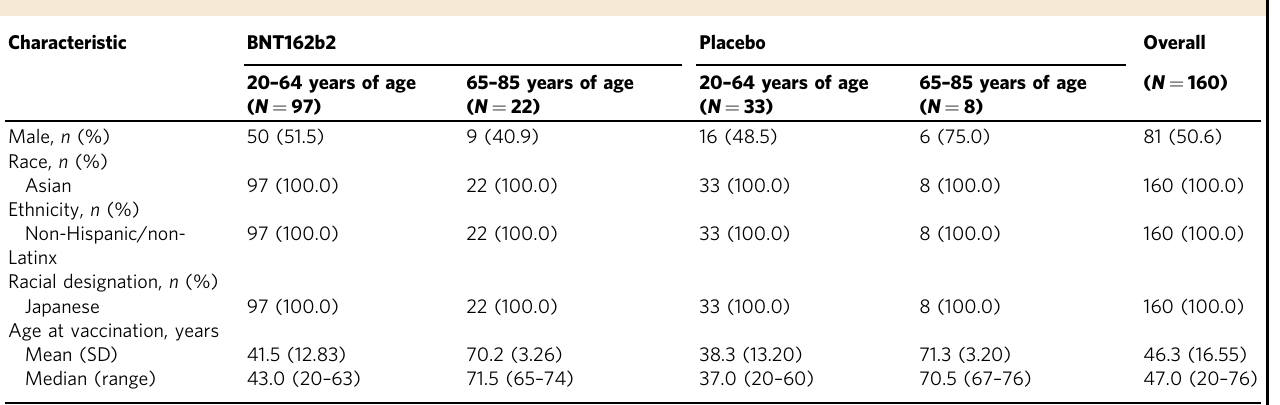
Table 1 Demographic characteristics of